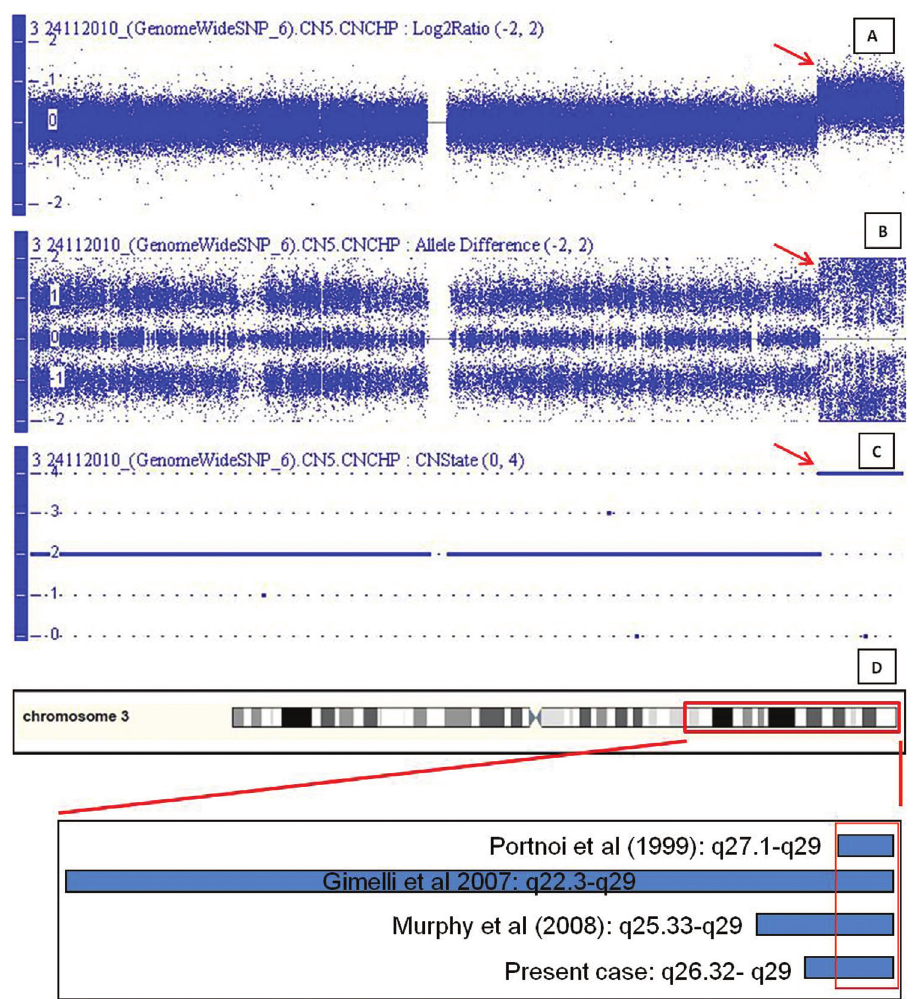
Figure 3 - Array genomic hybridization results. A) array profile of chromosome 3: weighted log2 ratio plot, the red arrow points to the 20.5 Mb copy number gain between 3q26.32-3q29; B ) array profile of chromosome 3: the allele difference plot is also highlighted by the red arrow; C ) array profile of chromosome 3: copy number state graph showing the 3q26.32-3q29 tetrasomy; D ) schematic figure of the copy number gain at 3q, blue bars indicate the range in three cases previously reported and in our